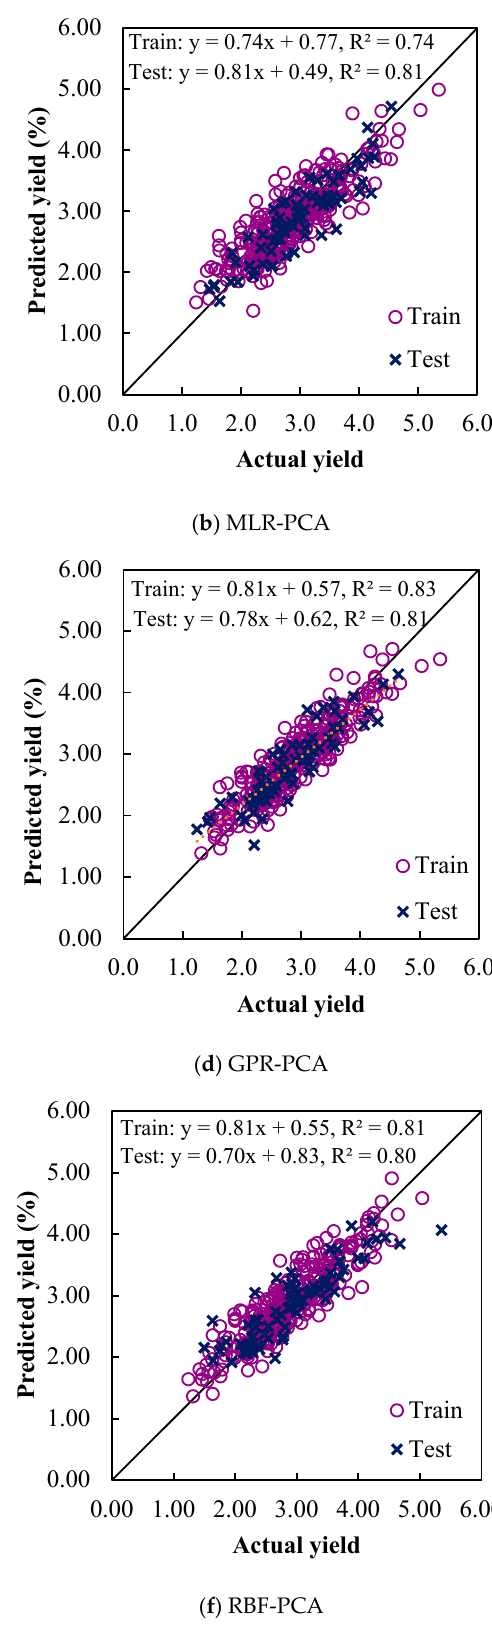
Figure 6. Correlations between actual and predicted SSY values of three ML and ML ‐ PCA models.